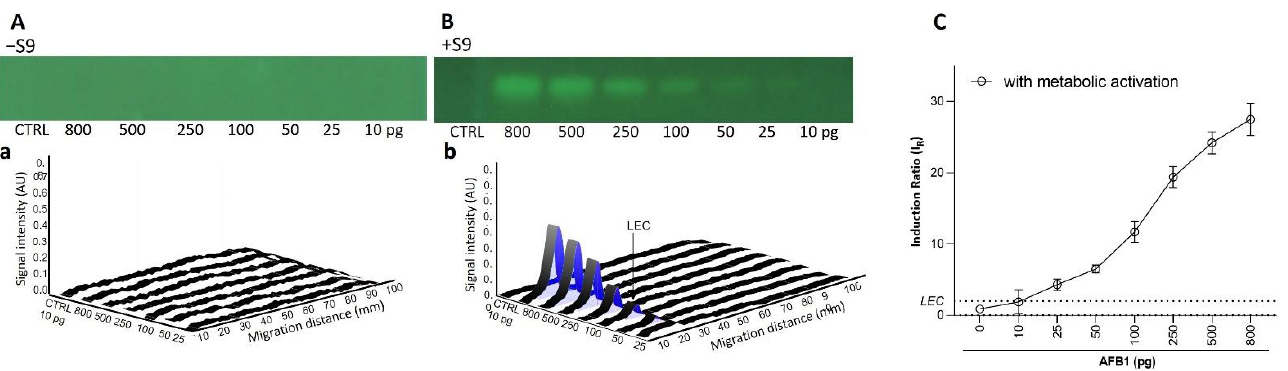
Figure 2. Dose – response effect for AFB1. Bioautograms at FLD 254 nm (region of interest shown) in absence ( − S9) ( A ) or presence (+S9) ( B ) of metabolic activation, with respective biodensitograms at 485/>500 nm (a and b). Dose – response curves with LEC (black dotted line at IR 2.0) ( C ).